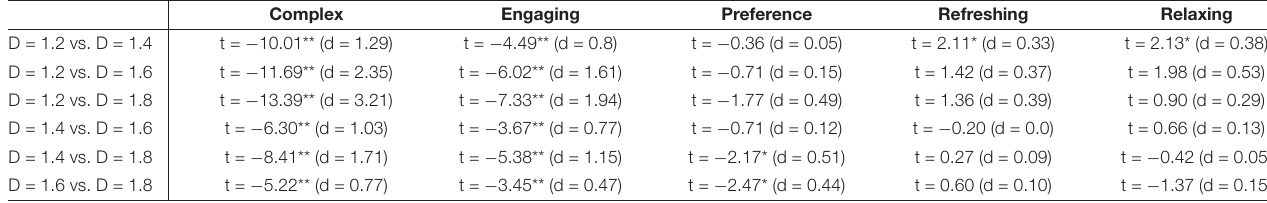
TABLE 3 | Experiment 2-paired samples t -tests across D -value and judgment. Complex Engaging Preference Refreshing